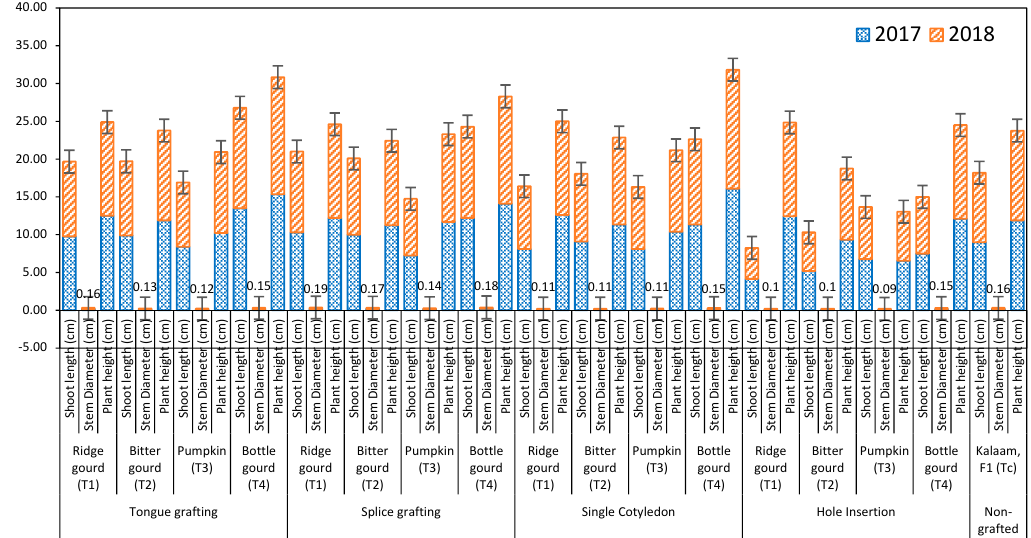
Figure 3. Effect of Scion/rootstocks combinations (grafting) on vegetative growth parameters of Figure 3. E ff ect of Scion / rootstocks combinations (grafting) on vegetative growth parameters of Cucumber fruit after 15 days during crop season 2017 and 2018. Cucumber fruit after 15 days during crop season 2017 and